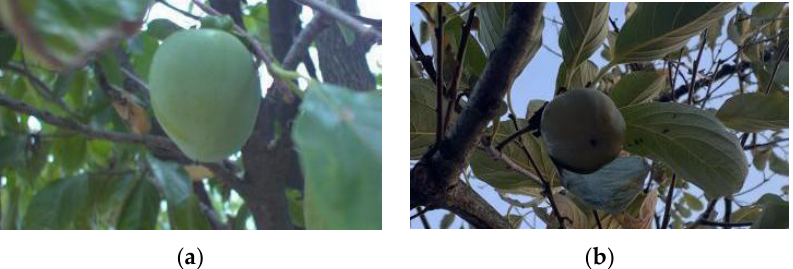
Figure 1. Sampling under different light rays. ( a ) Normal light. ( b ) Weak light.